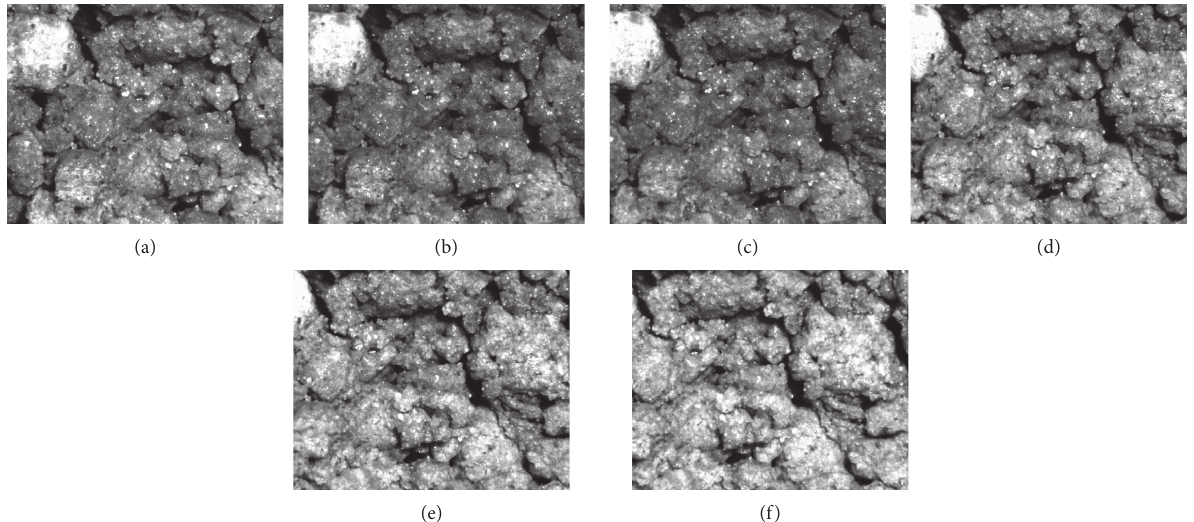
Figure 16: The continuous images under different tensile displacements in Zone 3: (a) L � 0.005 mm; (b) L � 0.030 mm; (c) L � 0.060 mm; (d) L � 0.085 mm; (e) L � 0.110 mm; (f) L � 0.125